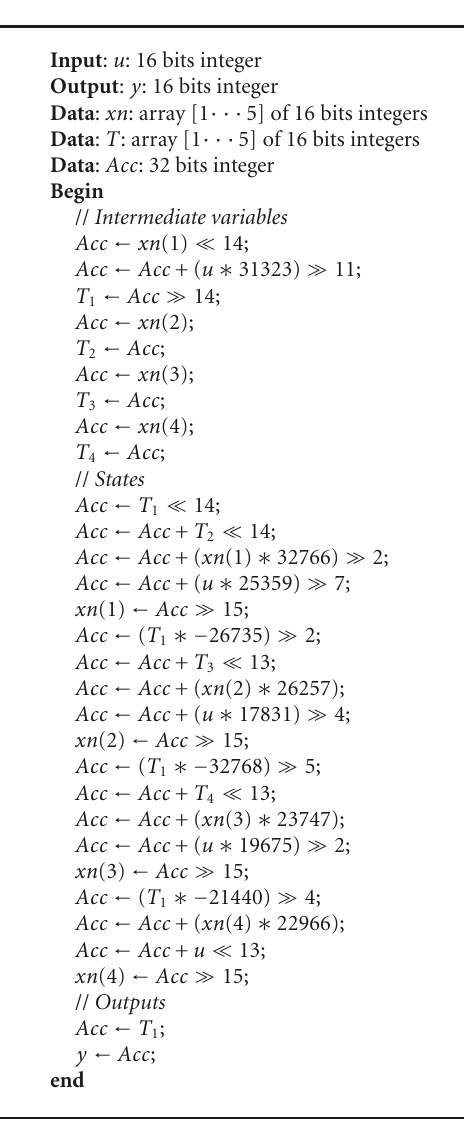
Algorithm 2: Z 9 implemented in 16-bit fixed